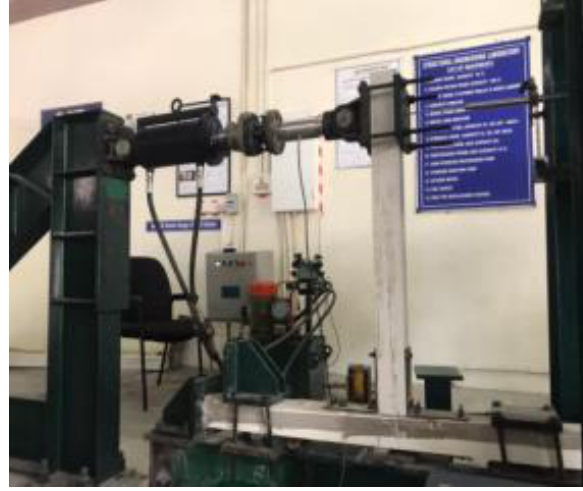
Figure 7. Experimental setup for lateral loading on beam-columns.